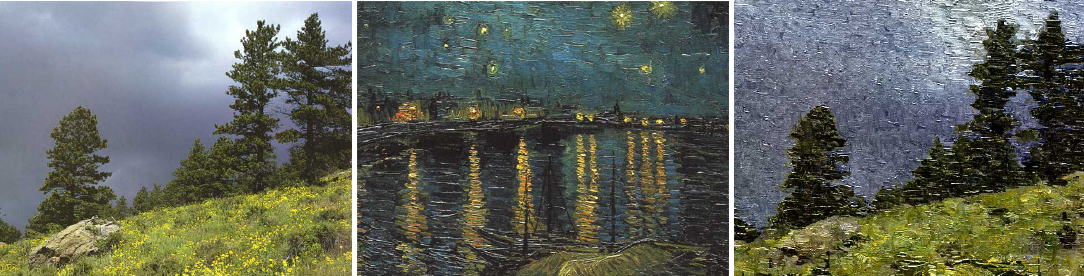
Figure 7. Our Image Analogies algorithm (Hertzmann et al. 2001), which stylizes a photograph in the style of a given artwork; in this case, Van Gogh’s Starry Night over the Rhône . Source photograph by John Shaw, used by permission; Van Gogh image in public